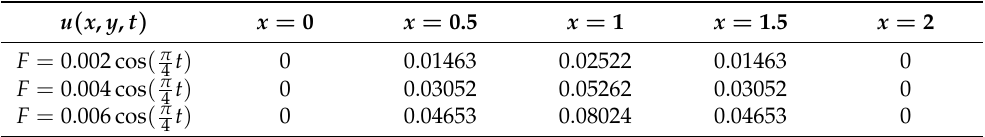
Figure 3. Plate displacements under three simple harmonic loads for ( a ) F = 0.08sin ( 0.01 t ) . ( b ) F = 0.4sin ( 0.01 t ) . ( c ) F = 0.8sin ( 0.01 t ) . Table 2. Displacement numerical solutions under simple harmonic loads.